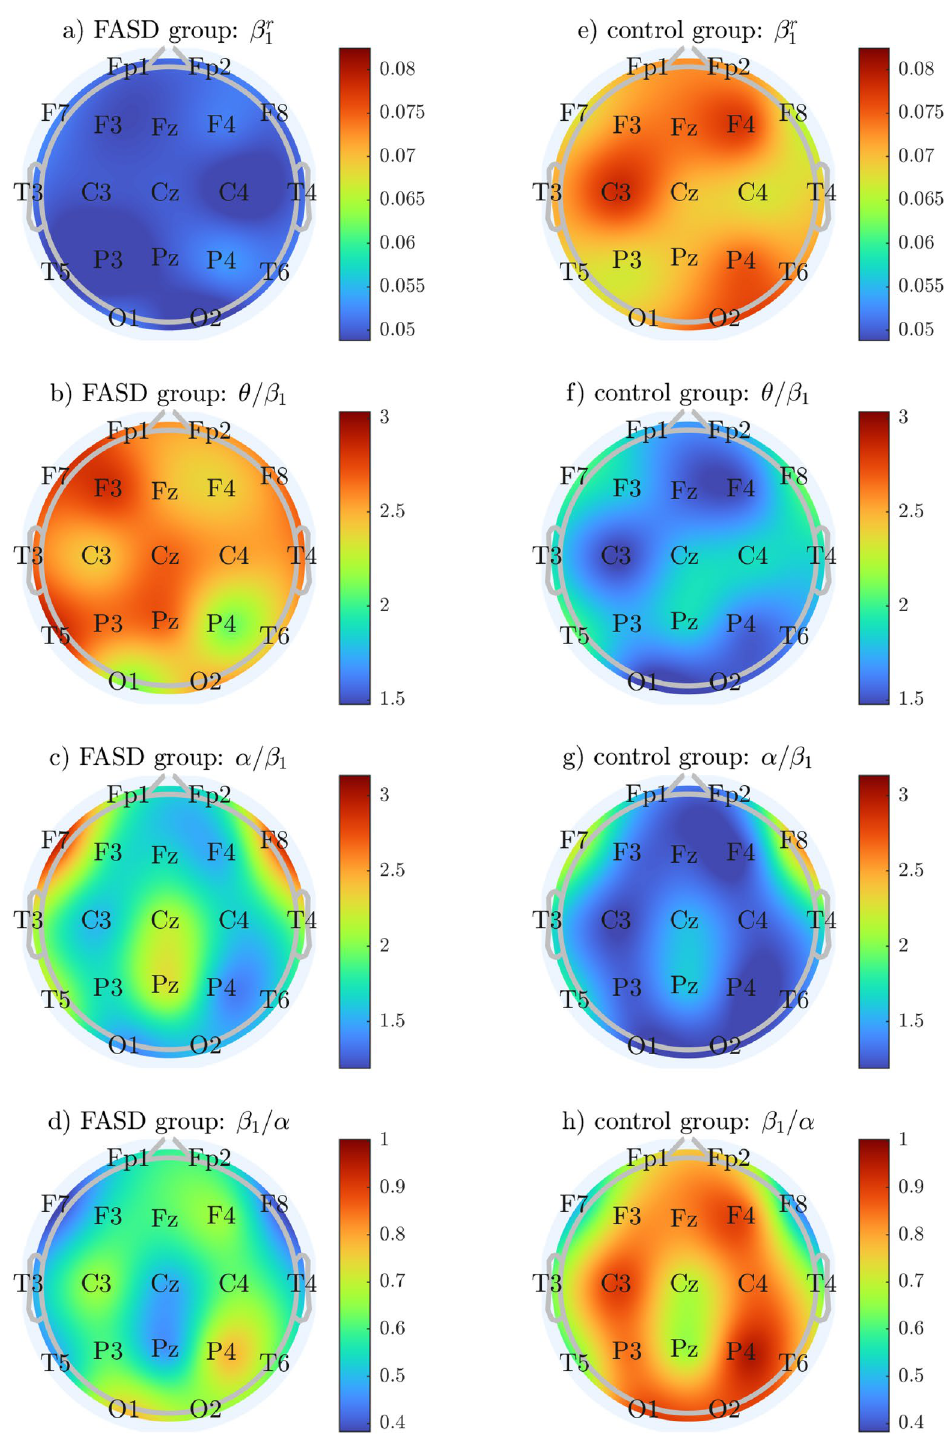
Figure 3. Topological plots of statistically significant features. Left and right column plots were obtained for FASD and control groups,